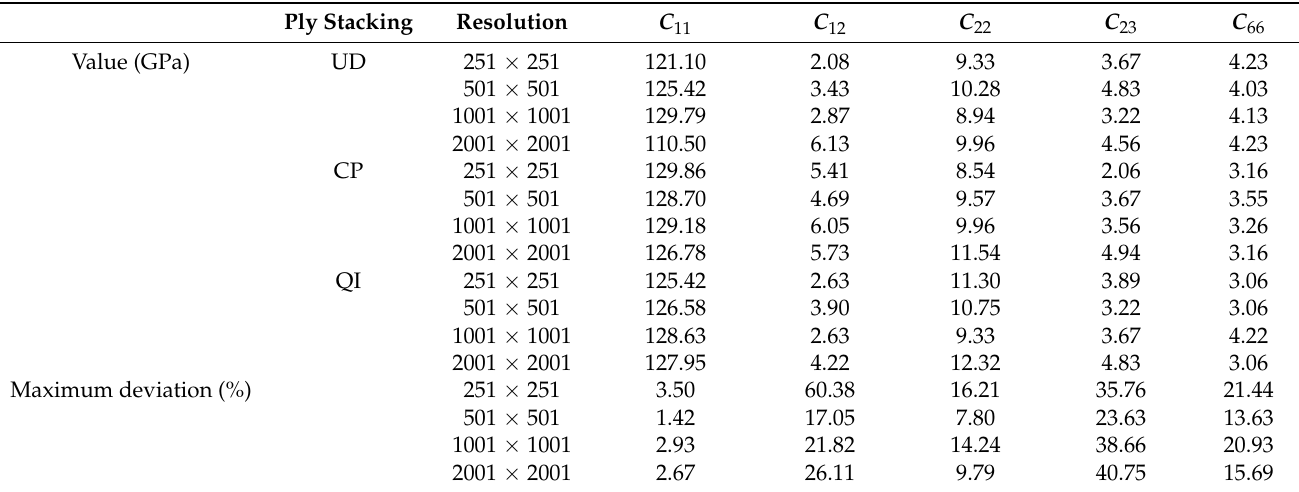
Table 5. Reconstructed stiffness matrix and maximum deviation